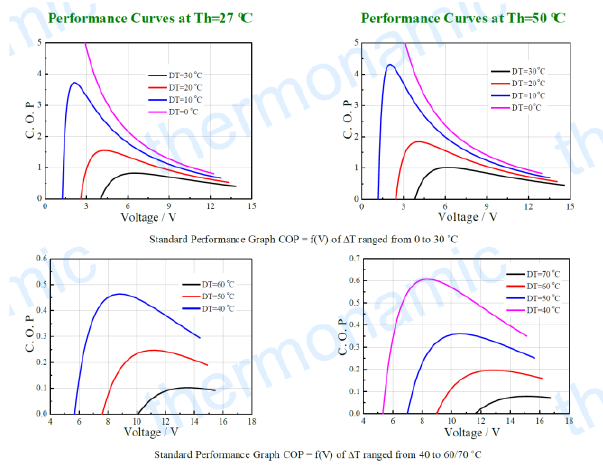
Figure 3: TEC Coefficient of